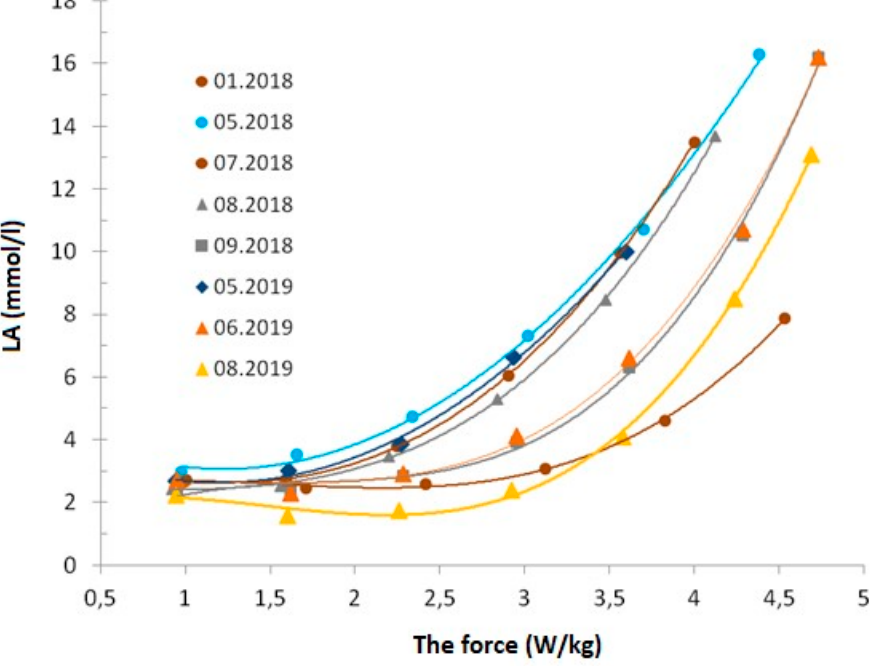
Figure 1. LA level (mmol/L) and maximum aerobic power obtained in the graded exercise test performed by the athlete in the periods studied.